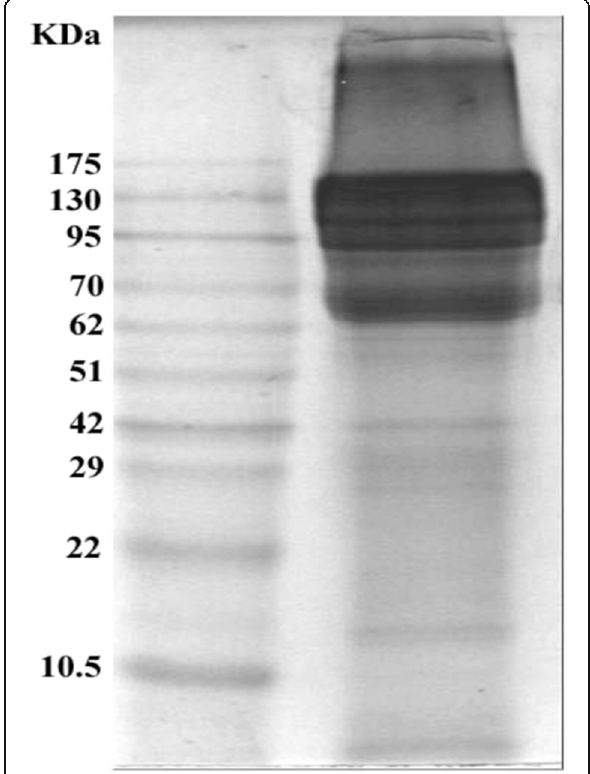
Fig. 1 10% SDS-PAGE of Bt Cry1C